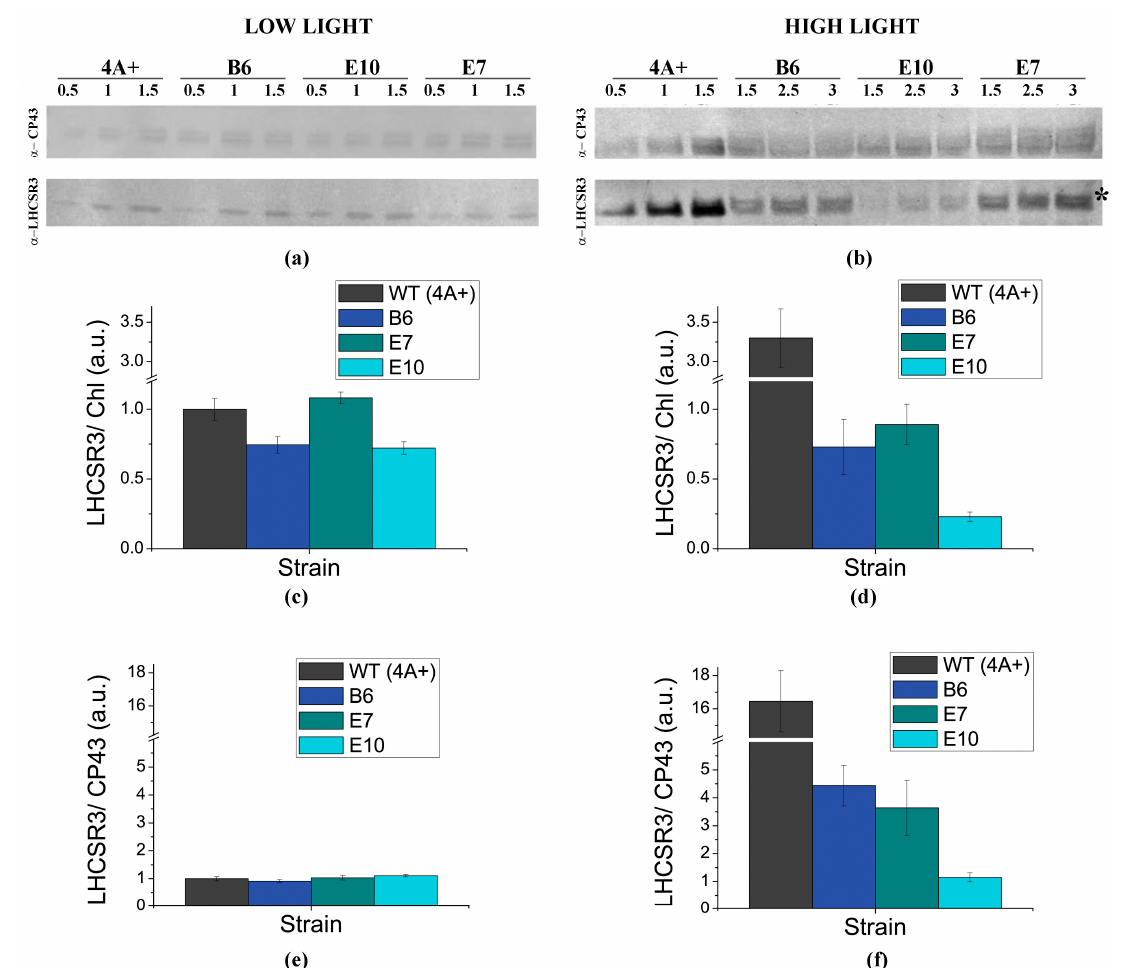
Figure 2. Immunoblot analysis of LHCSR3 accumulation in transformed lines compared to WT (4A+) strain. ( a , b ): immunoblot analysis for strains grown in low light ( a ) or high light ( b ) using specific antibodies recognizing LHCSR3 and CP43 as a control for protein loading. Proteins extracted from WT and transformed lines were loaded at three different dilutions as reported in the figure. The phosphorylated form of LHCSR3 is indicated by *; ( c – f ): accumulation of LHCSR3 in low light and high light treated cells determined by densitometric analysis of filters reported in ( a , b ) respectively. LHCSR3 content was normalized to the chlorophyll (Chl) content ( c , d ) or to CP43 content ( e , f ). The amount of LHCSR3/Chl and LHCSR3/CP43 ratios were then normalized the ratios detected in WT cells grown in low light conditions. In the case of WT grown in high light conditions, LHCS3/Chl and LHCSR/CP43 ratios were normalized to the levels detected for WT cells grown in low light according to results reported in Figure S2. Values in (c, d, e, f) are indicated as arbitrary units (a.u.) with standard deviation reported as error bar ( n = 3).